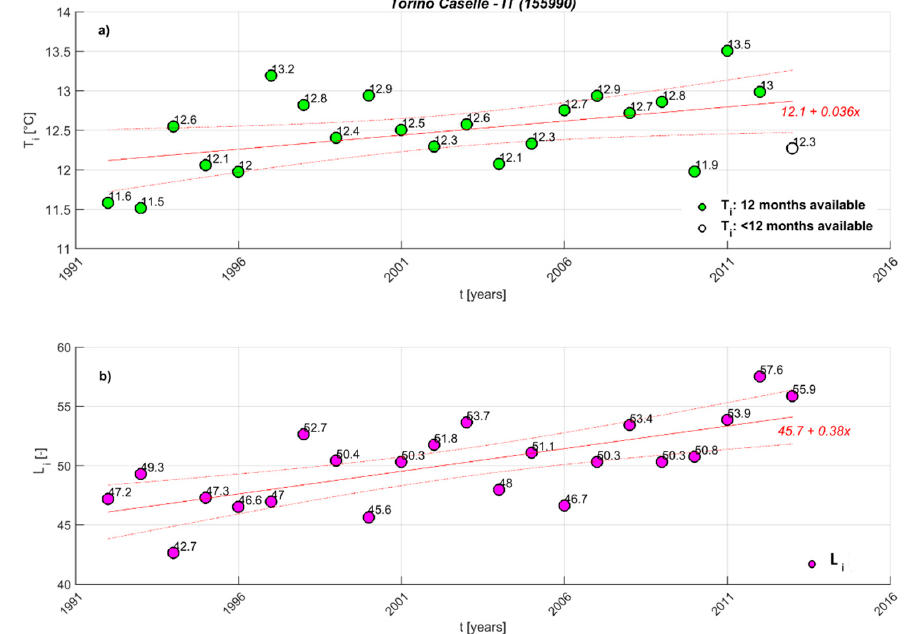
Figure 4. Linear regression trend lines of air temperature T ( ◦ C) and nightlights L (-) records. Example for the air temperature station of Torino Caselle, IT (Berkeley Earth ID: 155990). ( a ) Temperature time series: green colored dots refer to annual temperature values in the presence of 12 months of available data per year. Empty dots refer to temperature values obtained from the gap-filling procedure. The linear regression line and equation (Equation (3)) are shown in red. The average annual temperature for year i is also reported. ( b ) Nightlights time series: purple colored dots refer to annual Digital Number values, where a 3 × 3 km buffer is considered L . The linear regression line and equation (Equation (4)) are shown in red. The average annual Digital Number value for the year i is also reported.